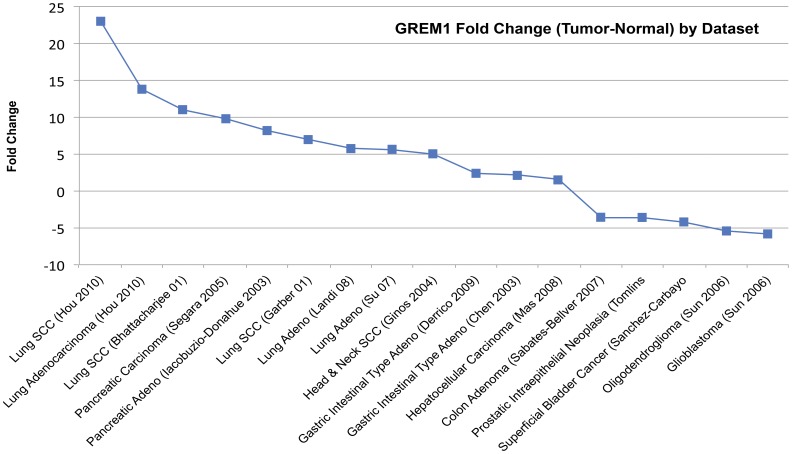
Fold-change in Gremlin expression between tumor and normal sample by microarray dataset.Datasets containing tumor and normal sample and probes for GREM1 were selected and a two-tailed, unpaired t-test was conducted between log-transformed and median-centered expression values for GREM1 probes in tumor and normal samples. Datasets representing 17 tumor-normal comparisons contained significant (p<.001) differences in GREM1 expression between tumor and normal samples.